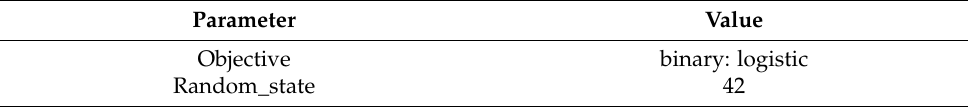
Table 6. Optimized parameter values for Extreme Gradient Boosting